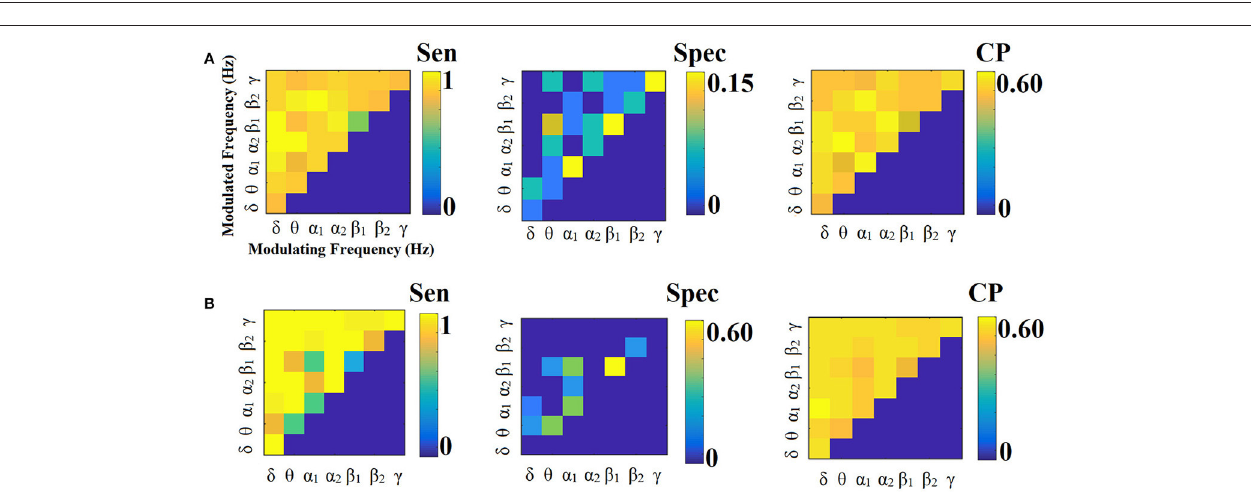
FIGURE 8 | Network topology of the selected edge-weighted features using the iPLV connectivity estimator for θ : β 1 and α 2 intra-frequency coupling. The two network topologies differ on their ROI representation approach. (A) PCA ROI representation for θ : β 1 . (B) Centroid ROI representation for α 2. The 90 ROI are illustrated circularly with 45 per hemisphere (left – right semi-circular distributions).